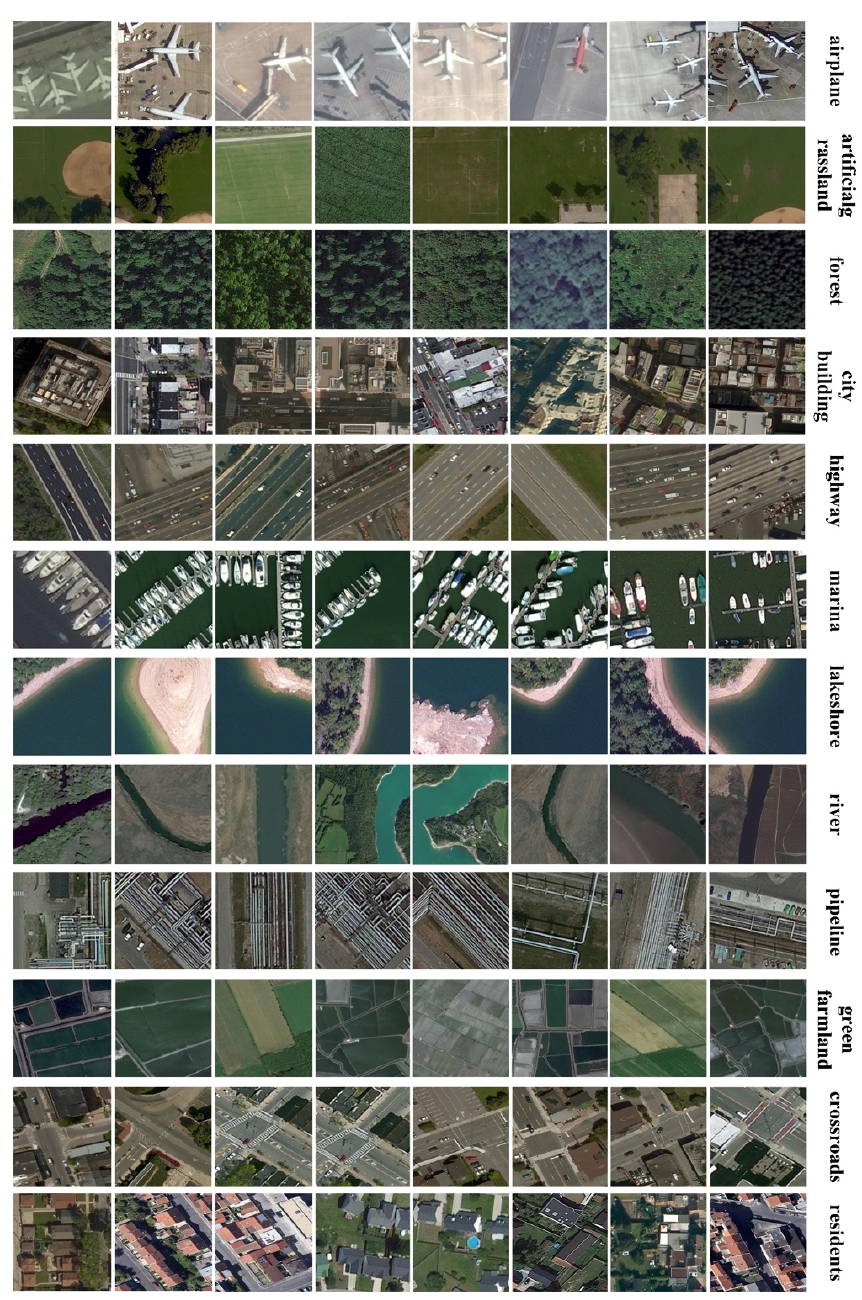
Figure 7. Samples of